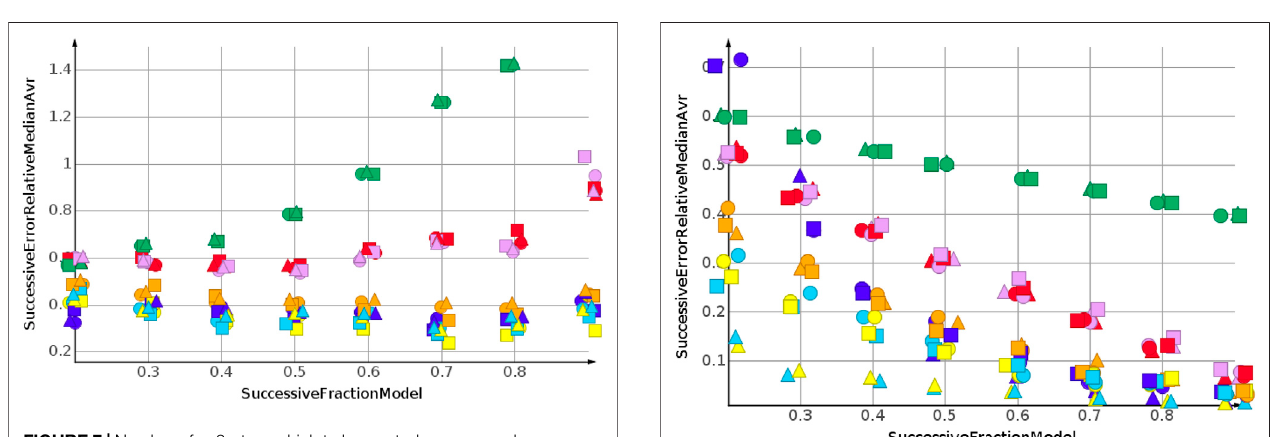
FIGURE 7 | Number of sp3-atoms, high to low sorted response values.